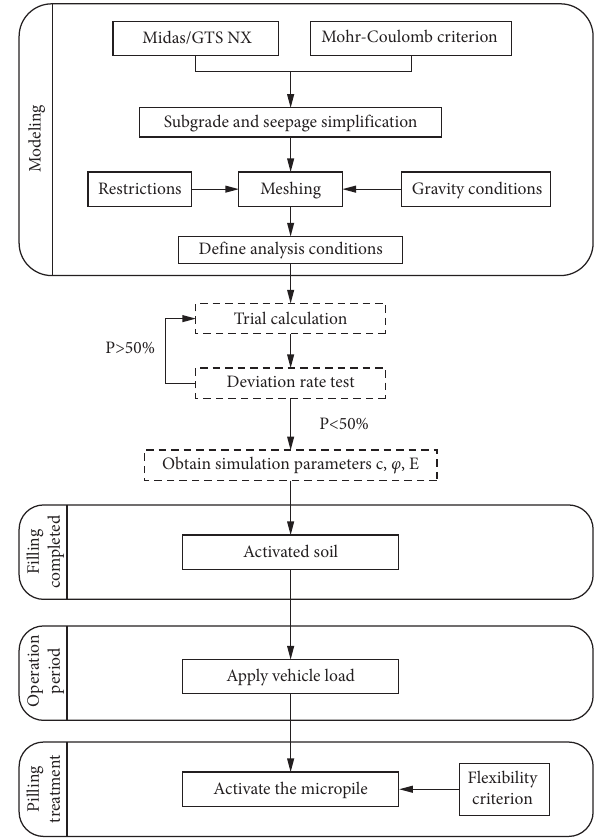
Figure 4: Procedural flowchart for modeling and Table 1: Physical and mechanical parameters of various soil layers.